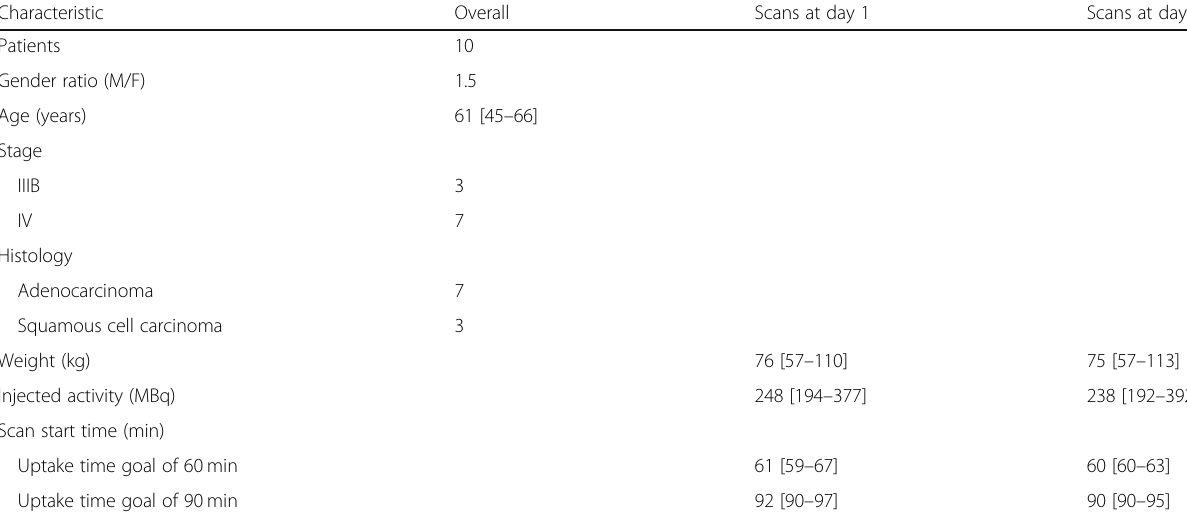
Table 1 Patient demographics and scan characteristics